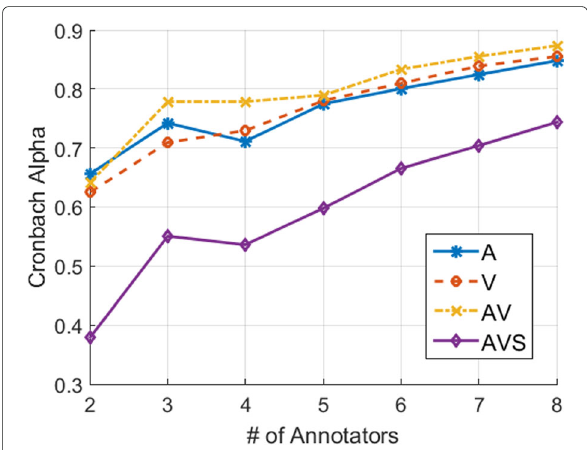
Fig. 2 Inter-annotator agreement showing Chronbach α for eight users on the movie